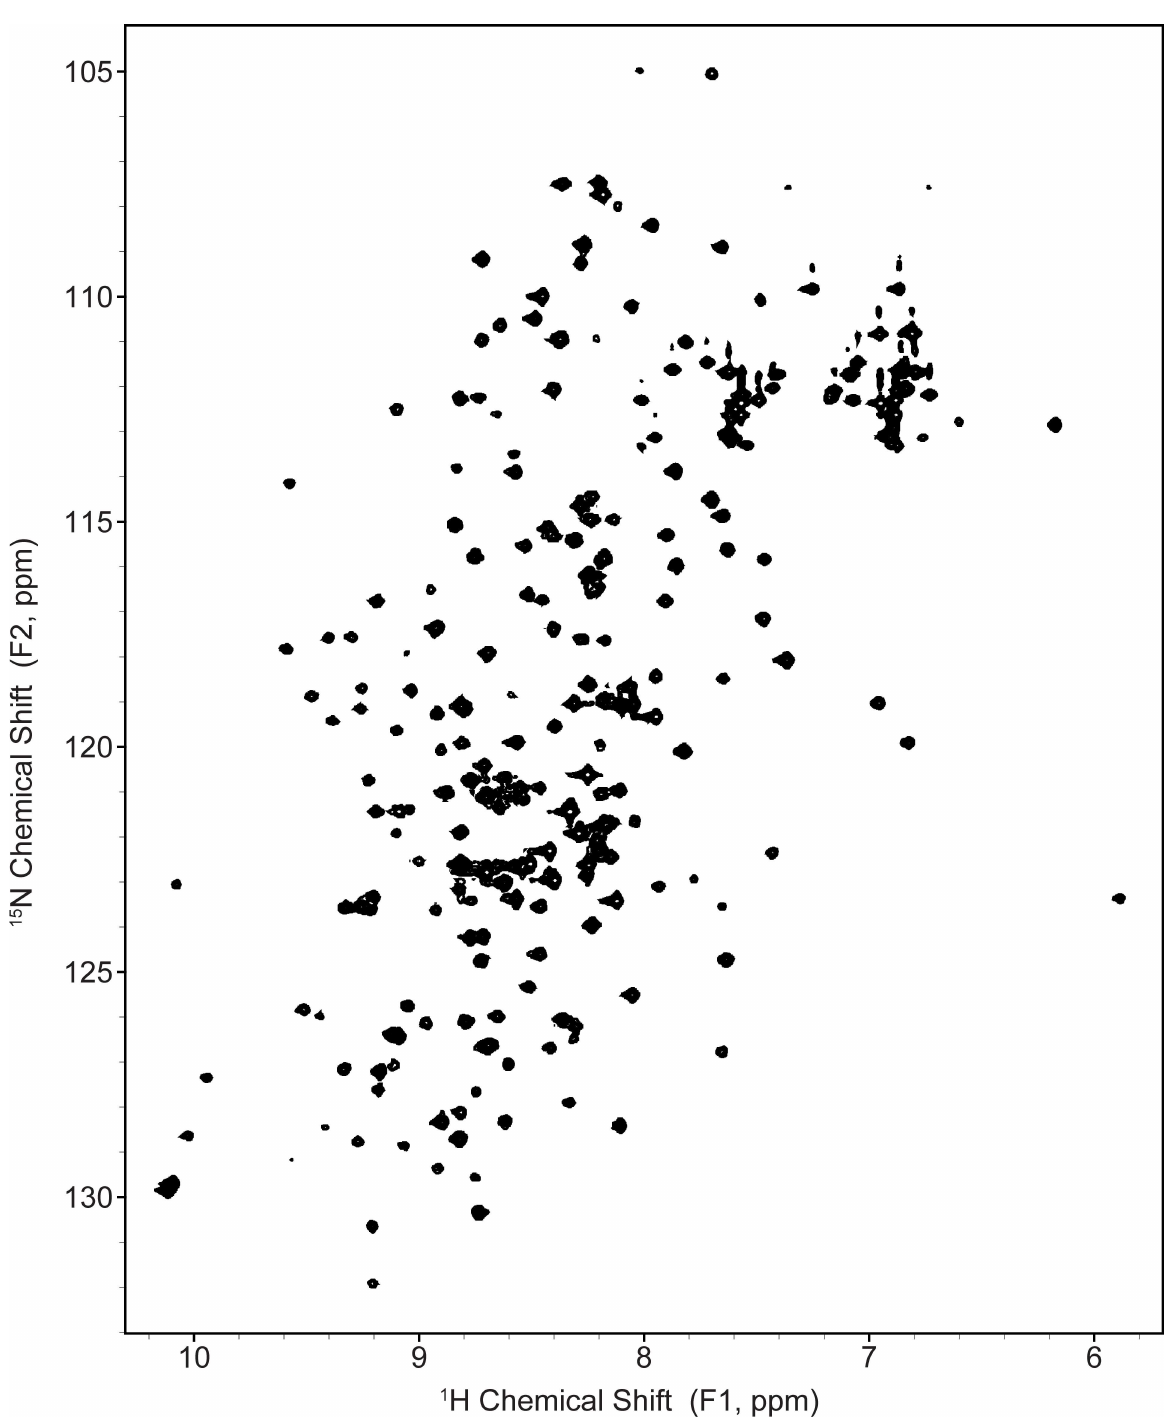
Fig 2. 1 H- 15 N 2D HSQC correlation spectrum. Solution NMR fingerprint spectrum of 100 μ M uniform 13 C, 15 N sTF in 50 mM sodium phosphate(pH 6.5), 50 mM NaCl, 5% DSS, 10% D 2 O, 0.1% NaN 3 acquired at a variable temperature set point of 35˚C on a Varian/ Agilent VNMRS 17.6 T (750 MHz 1 H frequency)